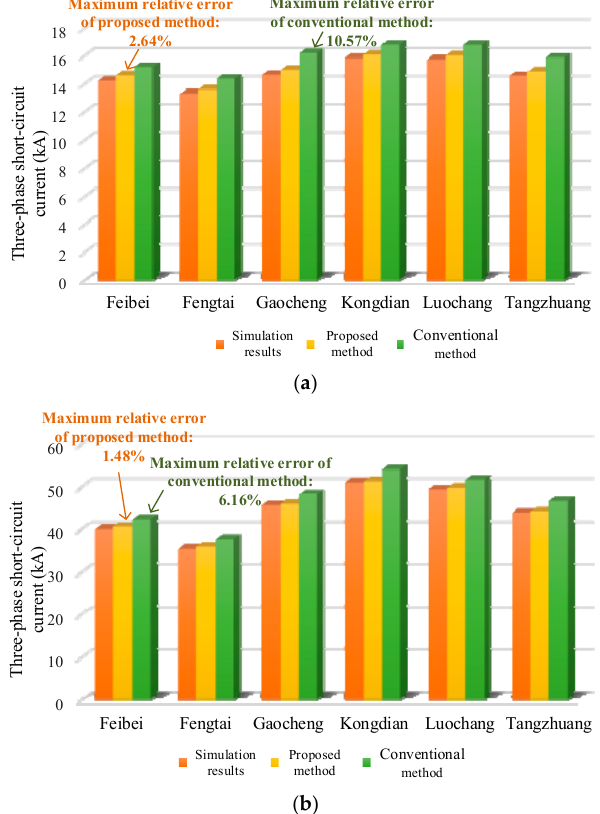
Figure 13. Three-phase short-circuit current of substations. ( a ) steady short-circuit current; ( b ) initial AC component value.